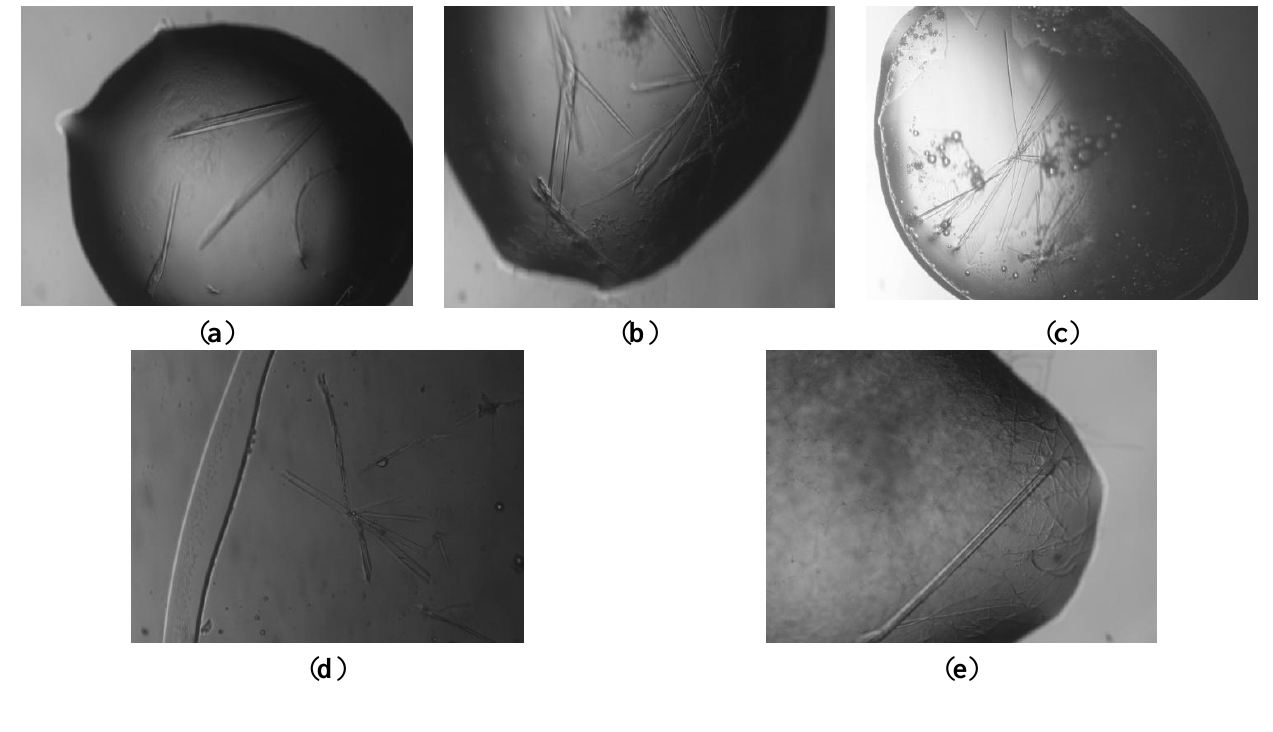
Figure 1. Image of typical bovine serum albumin (BSA) crystals grown by vapour diffusion ( a – e ). Crystals obtained from a crystallization solution containing 22–24% w/v MPEG 5K, 0.2M MgCl , 0.1 M Tris HCl pH 7.8 ( a – c ) and 8 ( d–e ) and protein 2 concentration of 20.0 mg mL –1